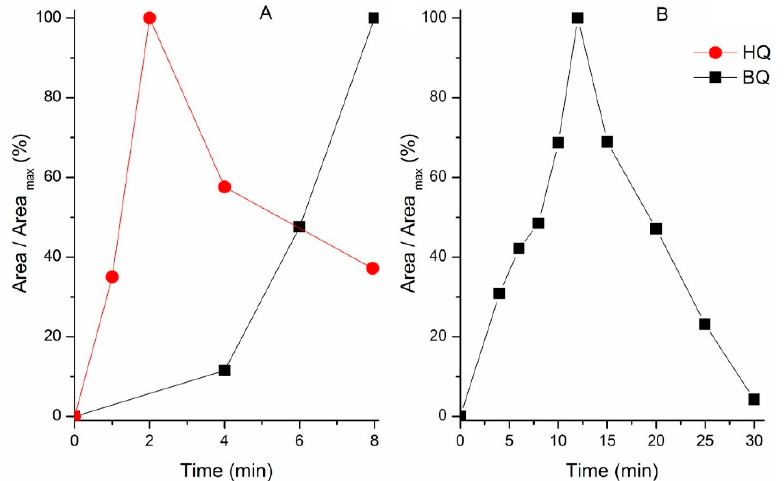
Figure 2. The percent evolutions of the peak areas of hydroquinone (HQ) and 1,4-benzoquinone (BQ) in ( A ) Mix 2 (MP+PP) and ( B ) Mix 3 (MP+PP+PCT) throughout the ozonation reaction. The peak areas were obtained by the integration of the chromatogram peak in the HPLC analysis.